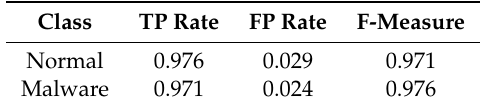
Table 17. Accuracy comparison of the proposed model on NSL-KDD (Test+ dataset). Table 16. Detailed accuracy at Stage 3 on the ADFA dataset.